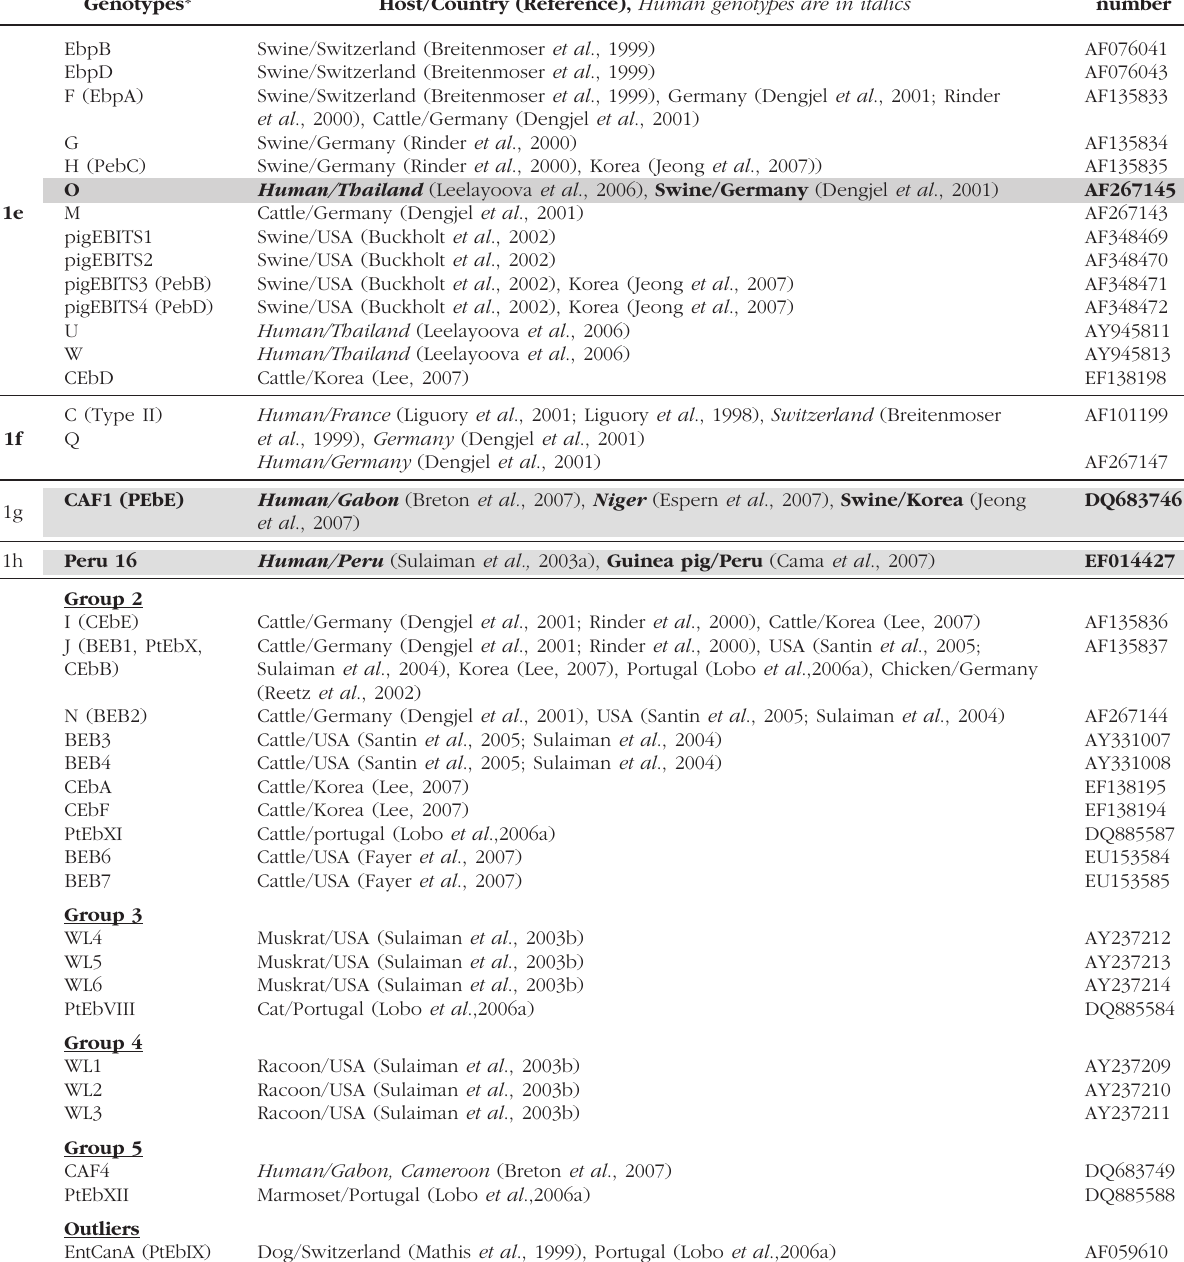
Table I. – Epidemiological traits of the Enterocytozoon bieneusi genotypes. Genotypes found both in human and animals are listed in grey